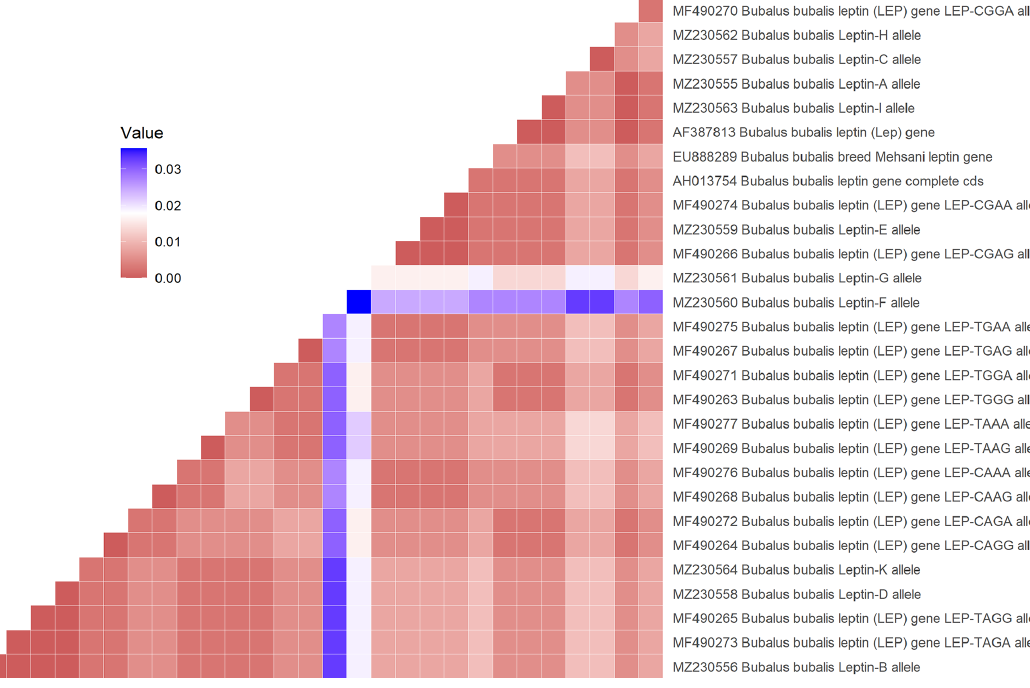
Figure 2. Heatmap showing the differential nucleotide (SNP) of the selected sequences of Lep gene region. Table 2. The nucleotide variations and amino acid changes in Lep amino acid